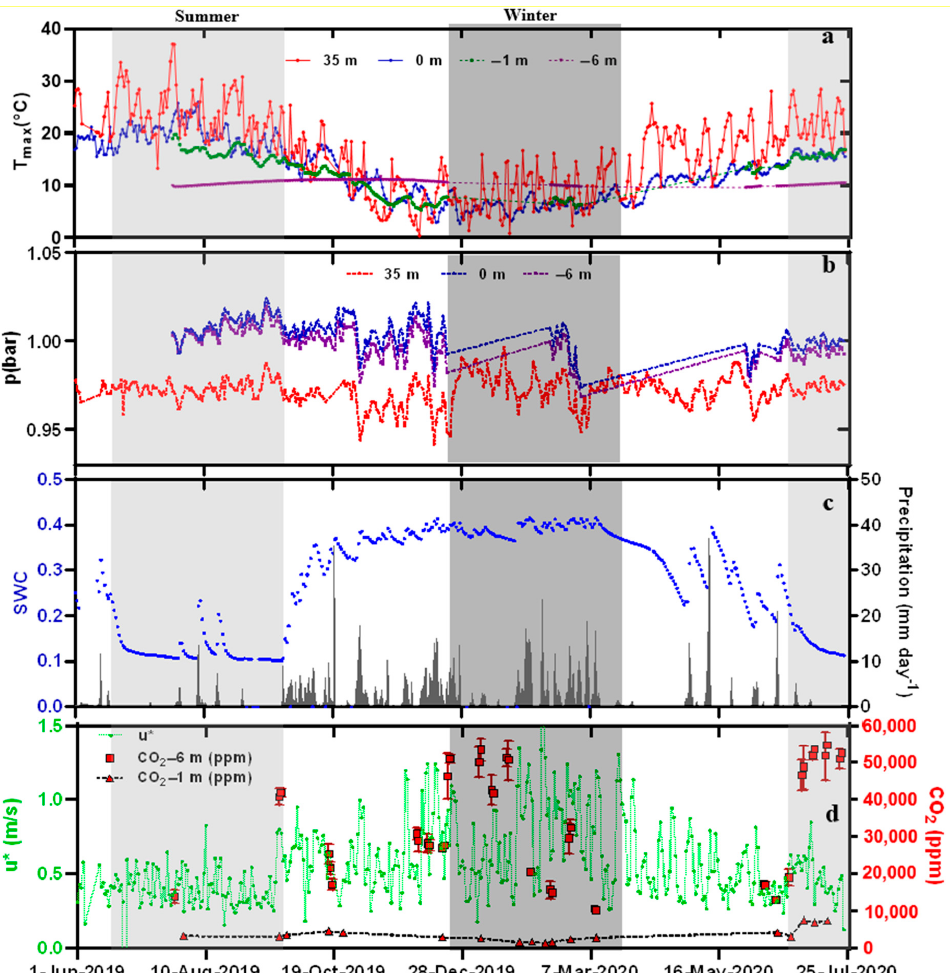
Figure 5. Time-series graph showing the daily max of temperature at various depth (35 m, 0 m, − 1 m, and − 6 m) ( a ), the daily average of atmospheric pressure measured at 35 and 0 m, and the soil-air pressure measured at 6m depth ( b ), soil water content (SWC) ( c ), precipitation ( c ), CO 2 molar fraction ( χ c) at 1 and 6 m depth ( d ), and friction velocity ( d ). Figure 5.d, the daily χ c (ppm) at -1 and -6 m and friction velocity (u*) above the can- Commented [M6]: 替换成这个图 opy are provided. The daily average of friction velocity (u*) was relatively higher during the winter (0.7 m/s) than in summer (0.4 m/s). The χ c generally increases as the depth, from the near-atmospheric layer (-1m) up to a few meters to the subsoil layer (-6m). This study demonstrates that subsoil CO 2 at 1 m depth is constantly lower than subsoil CO 2 at 6 m depth ranging from 1000-7000 ppm at -1 and 10000-60000 ppm at -6m. The χ c at -1 m was at the lowest in winter and highest in summer in June 2020. Meanwhile, the seasonal variation of χ c at -6m is somewhat weak. However, it can be seen that the rise of χ c at -6 m depth occurs together with the fall of u* and the decrease in SWC due to the absence of rainfall. The seasonal variation of u* is also weak, where it is found to be low during sum- mer and higher during winter, with an exception in early December 2019 to the end of February 2020. To better understand the general relationship between variables statisti- cally, the matrix correlation based on Pearson's is provided in Figure 6 .